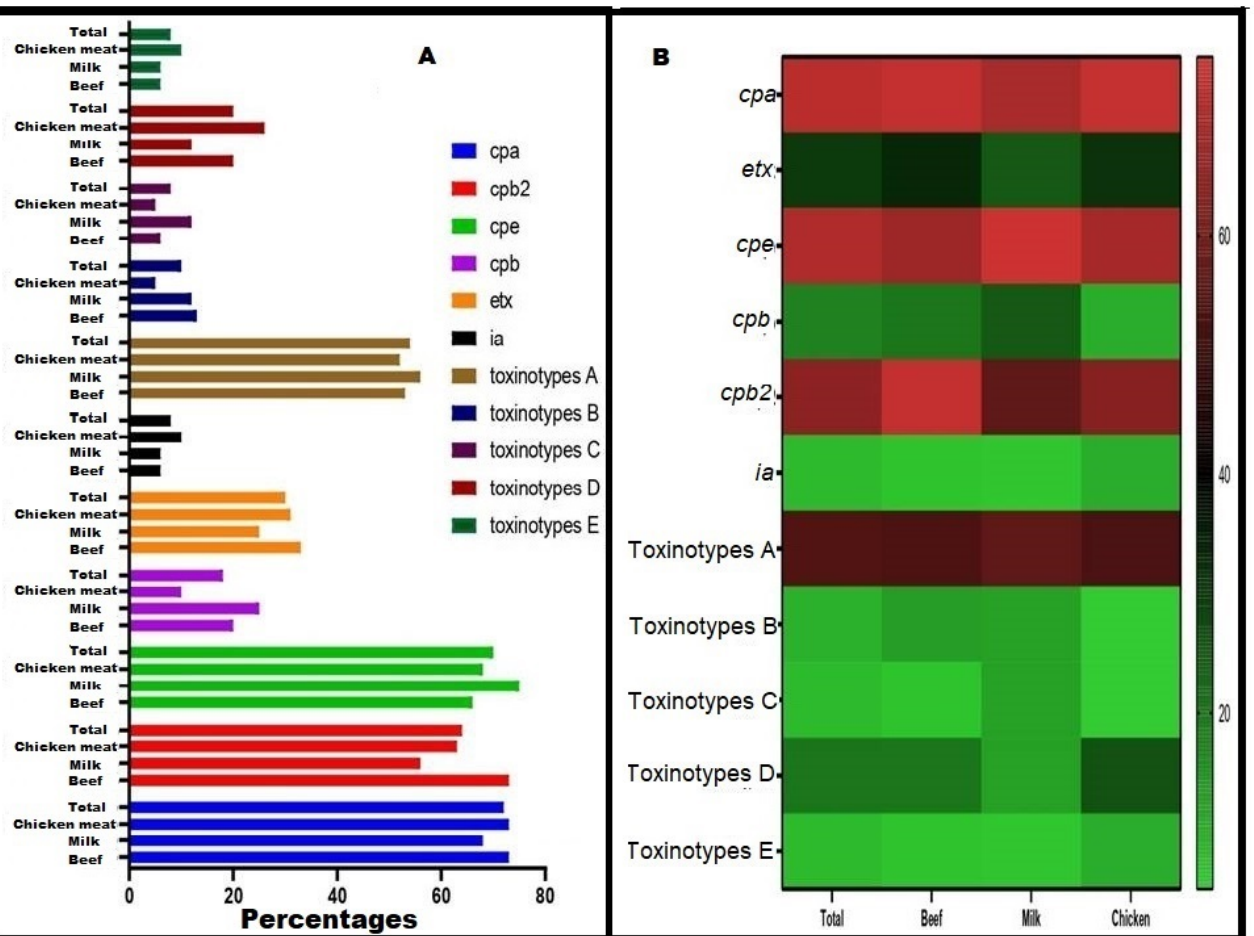
Figure 3. Distribution of toxinotypes and toxin genes among C. perfringens from chicken meat, milk, and beef samples. ( A ) Columns style using Graphpad prism, which showes the percentages of C. perfringens toxins and toxinotypes from each sample type. ( B ) Heat map style, in which the percentages of toxinotypes and toxin genes are color-coded on the right of the figure. The cpa, cpb, etx, ia, and cpe are C. perfringens alpha, beta, epsilon, iota, and enterotoxin genes, respectively; cpb2 is the C. perfringens beta2 toxin gene.